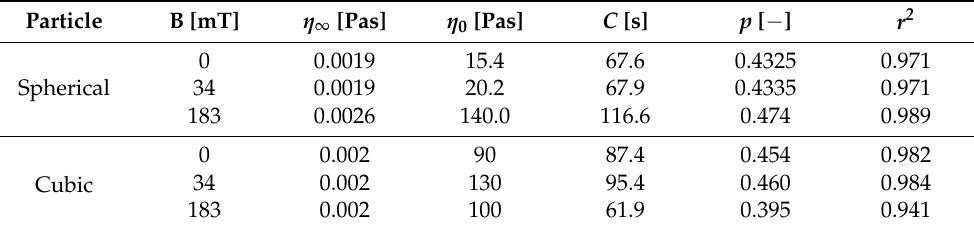
Table 5. The values of the fit parameters obtained by fitting the viscosity curves with the Carreau model for different magnetic flux density values for spherical and cubic nanoparticles at T = 25 ◦ C. Particle B [mT]